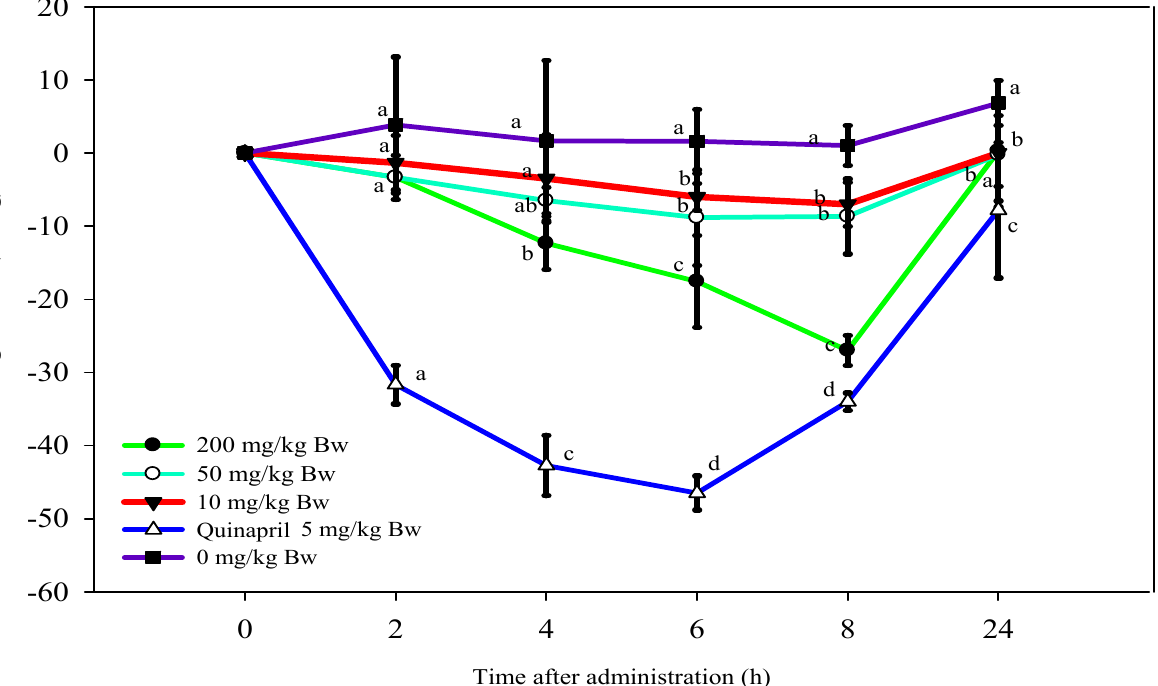
Figure 2. In vivo antihypertensive effect of GTN4H and quinapril in SHRs. Systolic blood pressure for 24 h after administration ( ■ 0, ▼ 10, ○ 50, ● 200 mg/kg BW) and compared with Quinapril ( △ 5 mg/kg BW). Values are mean ± SD, n = 6. Different lowercase letters within the same time after administration indicate significant differences ( p < 0.05).